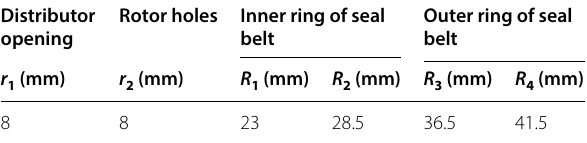
Outer ring of seal belt